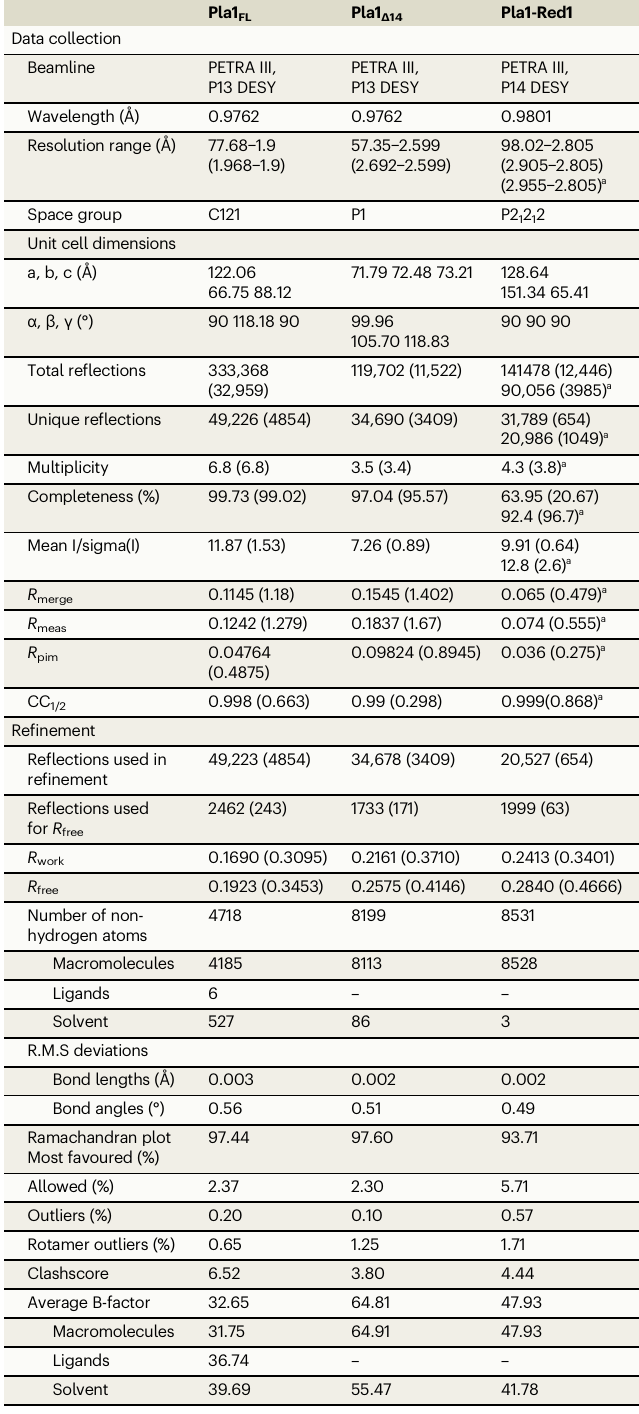
Table 1 | X-ray crystallography data collection and re fi nement